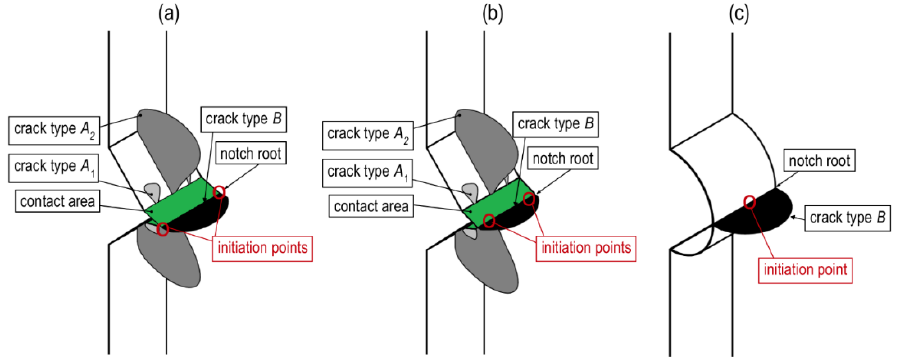
Figure 7. Cracks detected in specimens with ( a ) sharp V-notches; ( b ) rounded V-notches; and ( c ) U- U-notches during notches during unloading.